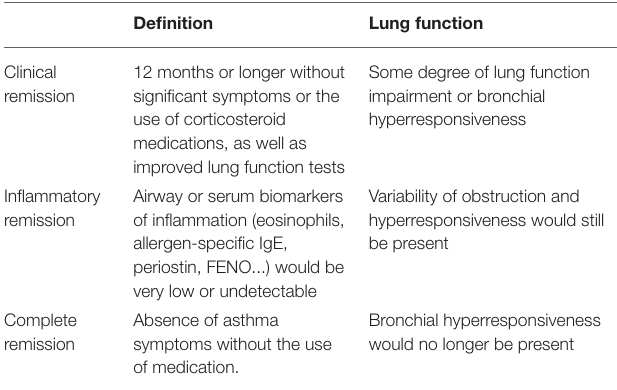
TABLE 1 | Types of asthma remission, their definition and implications on lung